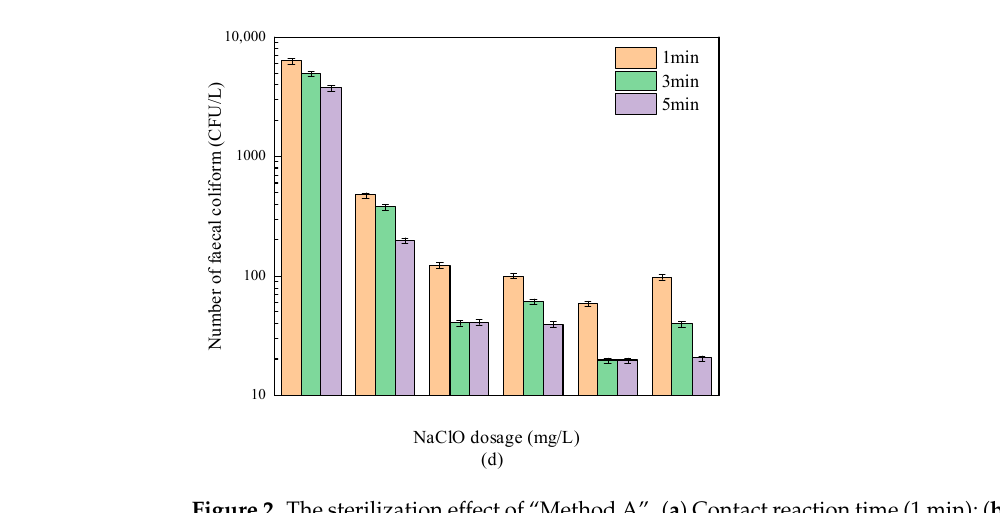
Figure 2. The sterilization effect of “Method A”. ( a ) Contact reaction time (1 min); ( b ) Contact reaction time (3 min); ( c ) Contact reaction time (5 min); ( d ) Comparison of sterilization efficacy of different contact reaction time.